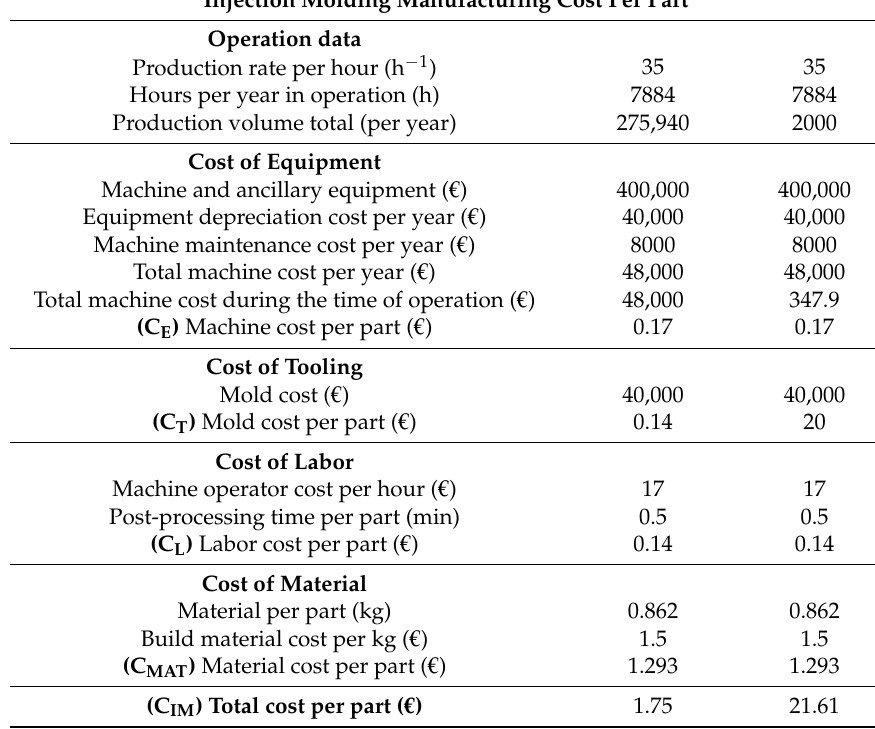
Table 4. Injection molding costs assessment for the original product at a maximum production rates and at an order level of 2000